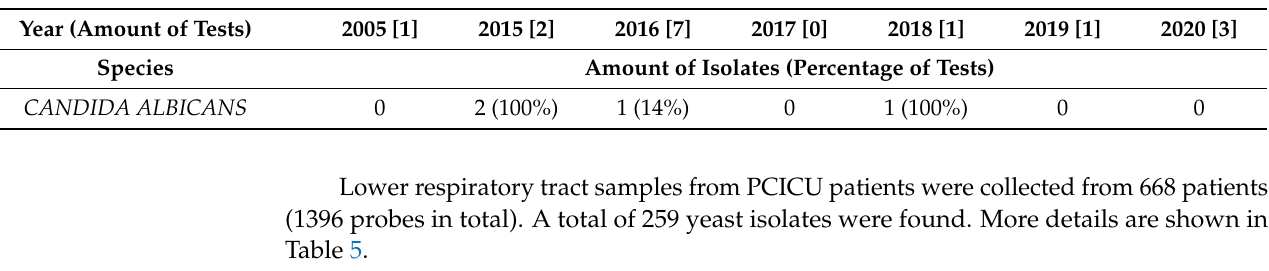
Table 4. Yeast species isolated from the upper respiratory tract samples from NICU patients.